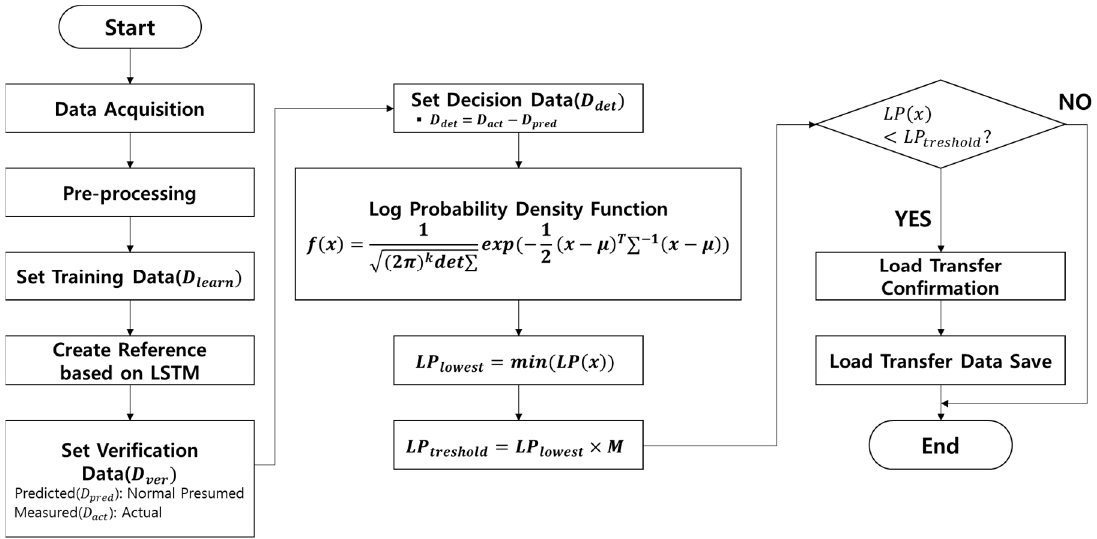
Figure 4. Machine learning based load transfer detection flow .